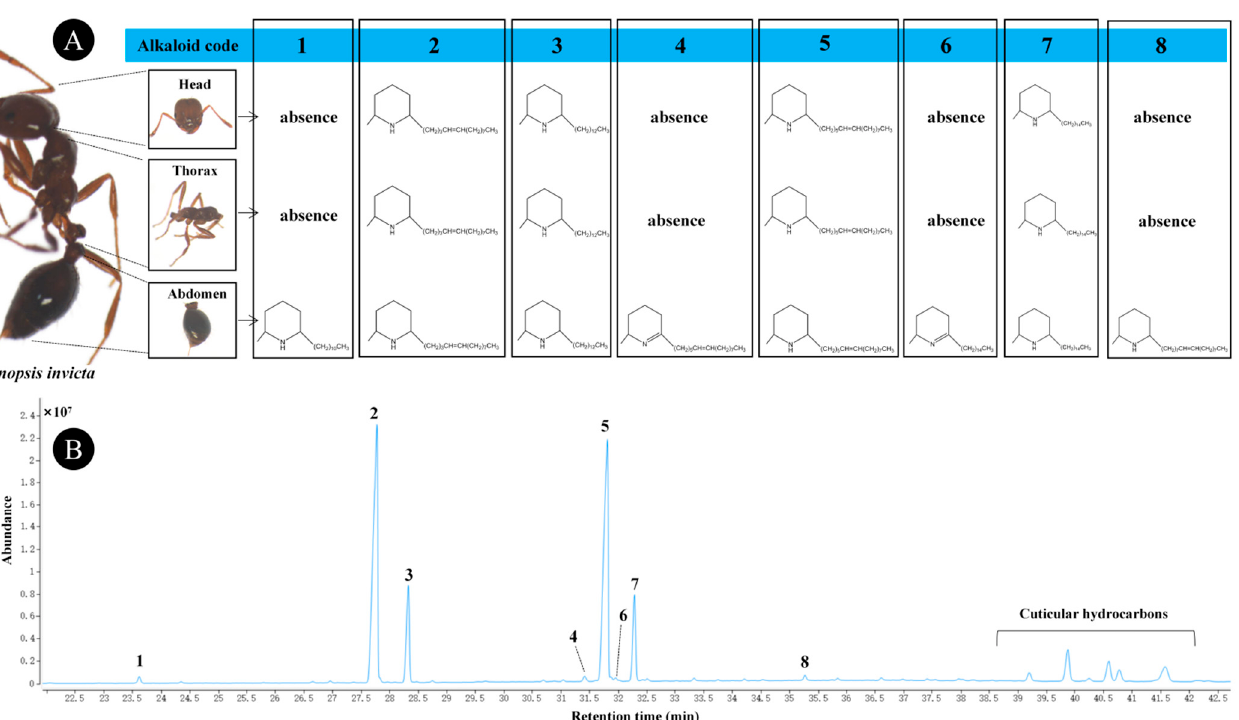
Figure 1. Gas chromatographs of hexane extracts obtained from different body parts (i.e., the head, thorax, and abdomen) of Solenopsis invicta workers. The types of alkaloids in these parts of S. invicta are shown in ( A ). The names of the various alkaloids (labeled 1–8) are 2-methyl-6-undecylpiperidine, 2-methyl-6-(4 (cid:48) -tridecenyl)piperidine, 2-methyl-6-tridecylpiperidine (3), 2-methyl-6-(6 (cid:48) -pentadecenyl)- 2,3,4,5-tetrahydropyridine, 2-methyl-6-(6 (cid:48) -pentadecenyl)piperidine (5), 2-methyl-6-pentadecyl-2,3,4,5- tetrahydropyridine, 2-methyl-6-pentadecylpiperidine, and 2-methyl-6-(8 (cid:48) -heptadecenyl)piperidine, respectively ( B